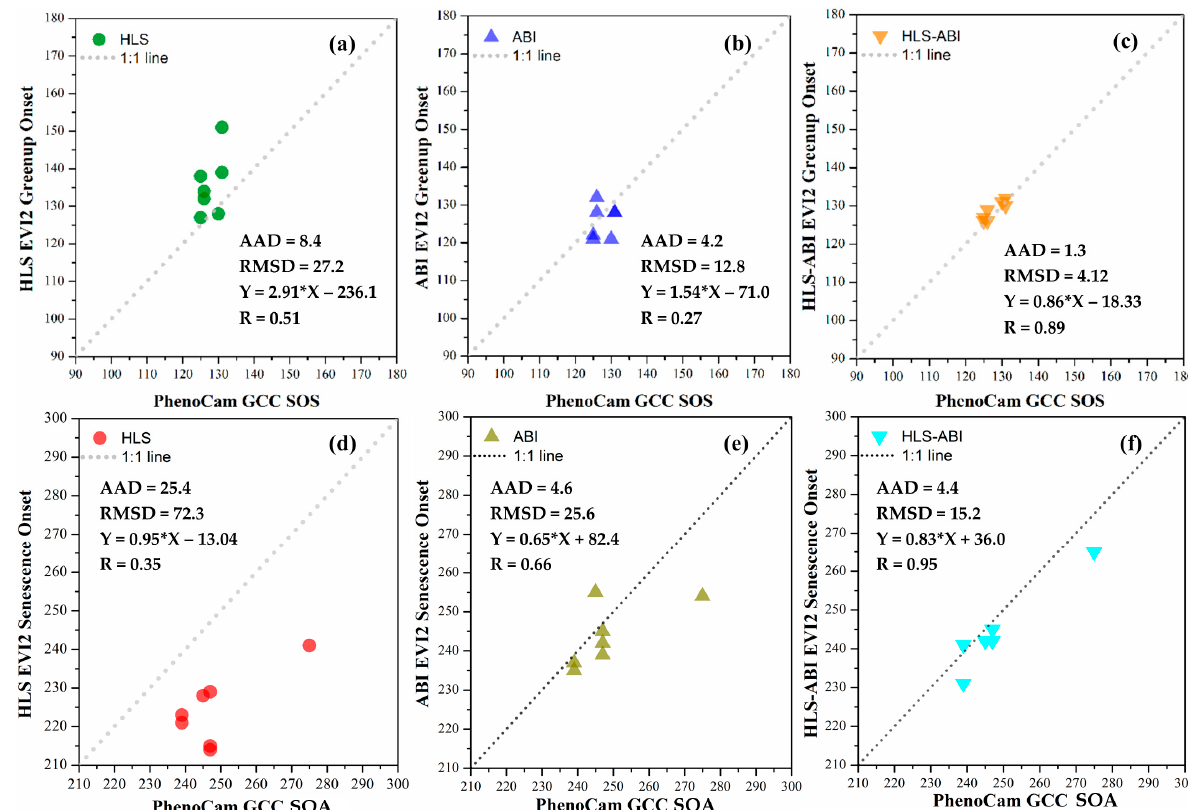
Figure 9. Comparison of greenup onset and senescence onset detected separately from ( a,d ) HLS, ( b,e ) ABI, and ( c,f ) HLS- ABI with 7 PhenoCam observations.